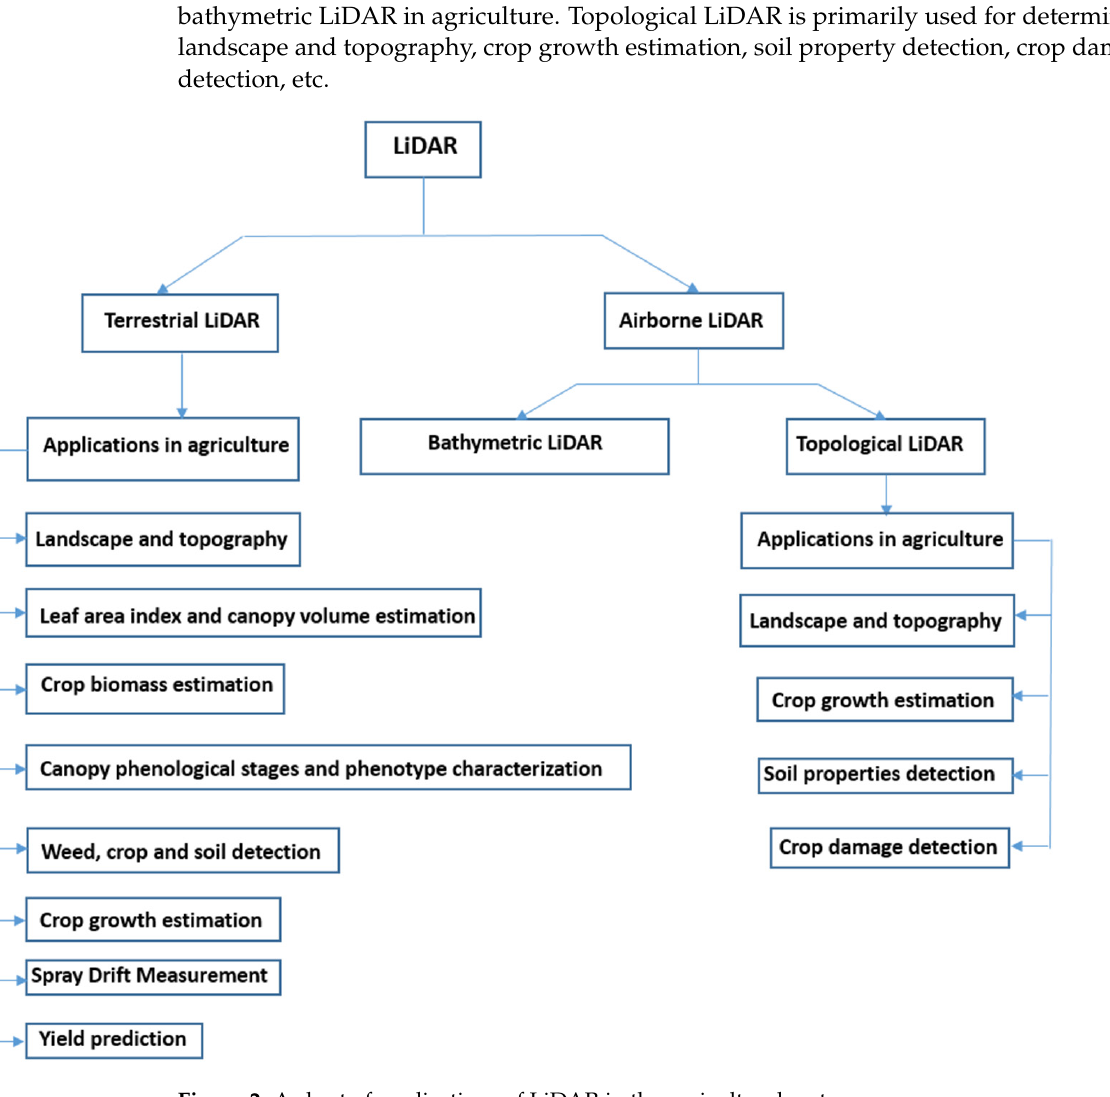
Figure 2. A chart of applications of LiDAR in the agricultural sector.